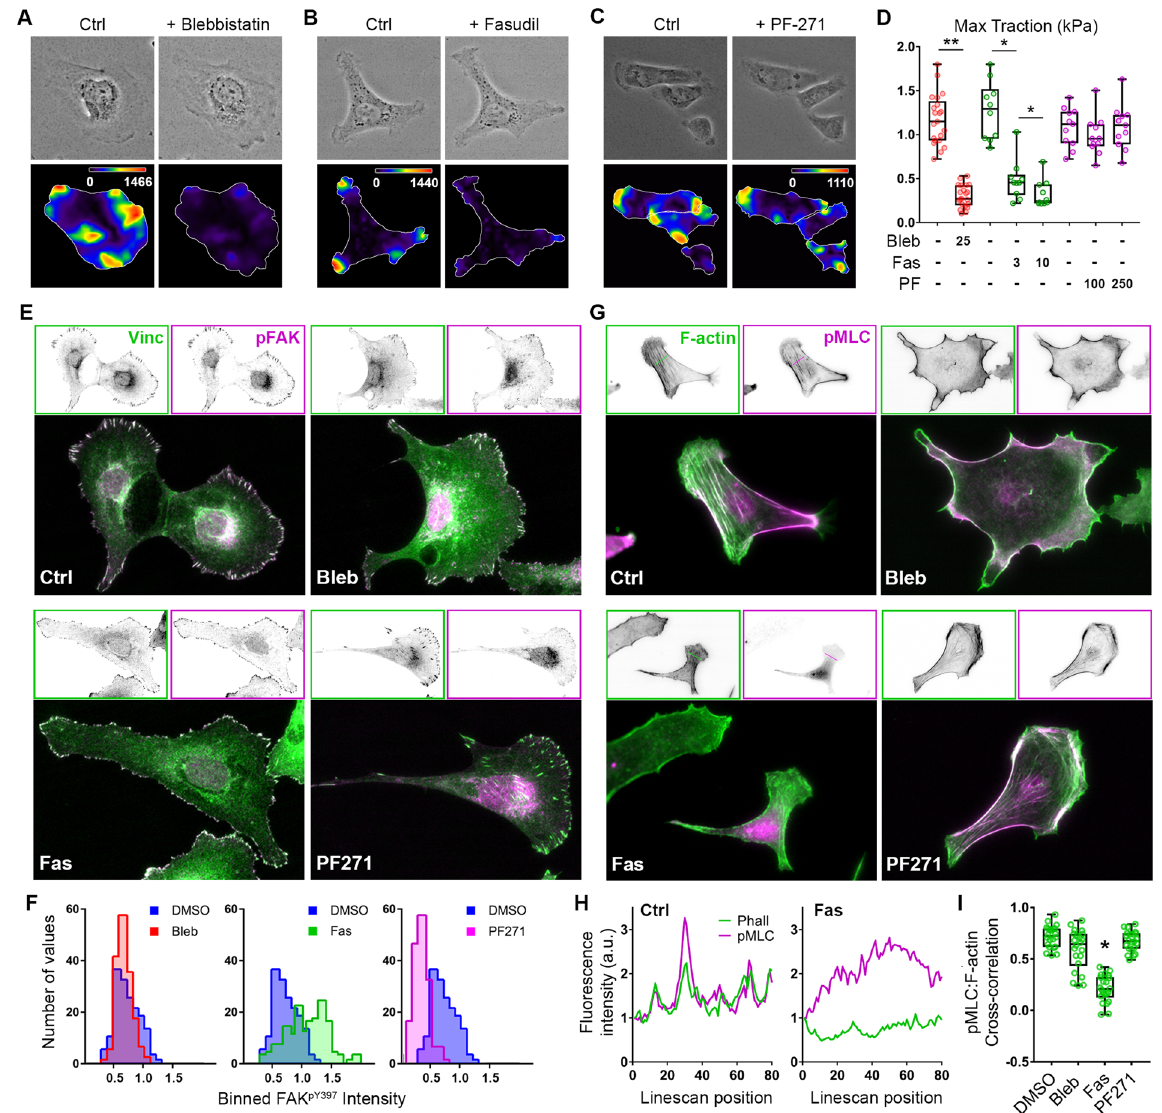
Figure 8. Cellular traction forces are dependent on ROCK activity and actomyosin contractility but independent of FAK activity. ( A – C ) Phase contrast images (top) and traction force maps (bottom) calculated for SKOV3 cells adhered to FN-coated 25 kPa hydrogels following 30 minute treatment with 25 μ M blebbistatin ( A ), 10 μ M fasudil ( B ), and 0.25 μ M PF-271 ( C ). ( D ) Maximum traction forces were analyzed following 30 minute treatment with 0.1% DMSO or the indicated compound ( μ M) (n = 10, 11, or 21 cells for blebbistatin, fasudil, or PF-271, respectively; * p = 0.002; ** p < 0.0001 using the Wilcoxon matched pairs test). ( E ) SKOV3 cells plated on 25 kPa hydrogels were treated with 0.1% DMSO (Ctrl), 25 μ M blebbistatin (Bleb), 10 μ M fasudil (Fas), or 0.25 μ M PF-562271 (PF271) for 30 minutes before being fixed and stained to visualize vinculin (Vinc) and FAK phosphorylated on Tyr397 (pFAK; pY397). (F) Individual focal adhesions were outlined by thresholding vinculin images and running a custom macro in ImageJ which transferred each focal adhesion ROI to the raw vinculin and pFAK images and measured each signal intensity. Mean pFAK intensity was normalized to mean Vinc intensity within each adhesion. Histograms represent binned, normalized pFAK levels within adhesion for each treatment compared to DMSO control (n ≥ 800 adhesions from ≥ 8 cells per treatment). ( G ) SKOV3 cells were plated and treated as in panel ( E ) then stained for F-actin and phospho- MLC. (H) Linescans of relative F-actin and phospho-MLC intensity (in arbitrary units (a.u.)) for representative control and fasudil treated cells were plotted from the dotted lines shown in ( G ). ( I ) Pearson’s cross-correlation analysis of phospho-MLC and F-actin intensity linescans as shown in ( H ). The graph depicts all of the data points (green symbols), with box & whisker plots showing maximum & minimum values (whiskers), the 25 th to 75 th percentiles (box), and the median value (box line) (n = 22 linescans (1 scan/cell) from 3 experiments; p < 0.0001 using the Kruskal-Wallis test with multi-comparisons (unannotated differences are not